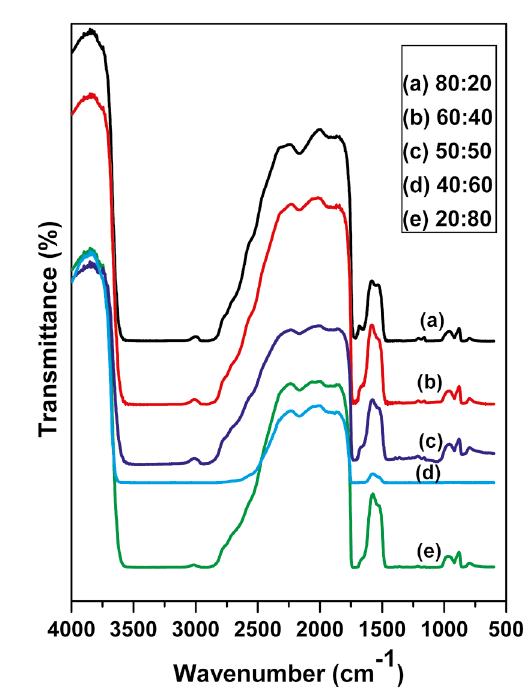
Figure 3. FTIR curves of PVA/MAA:EA blend samples (a) 80:20 (b) 60:40 (c) 50:50 (d) 40:60 (e) 20:80